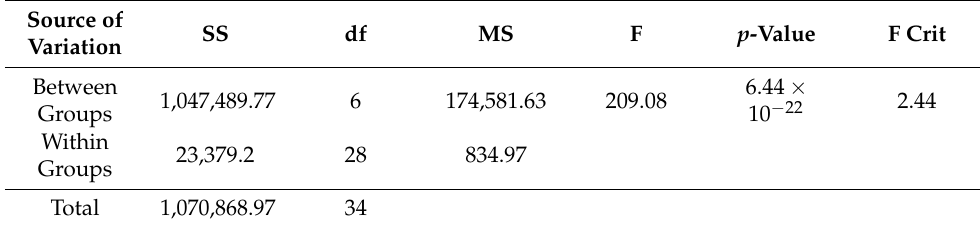
Table 6. Resulting ANOVA for tensile strength of GFRP laminates tested under temperatures of − 80 − 100 ◦